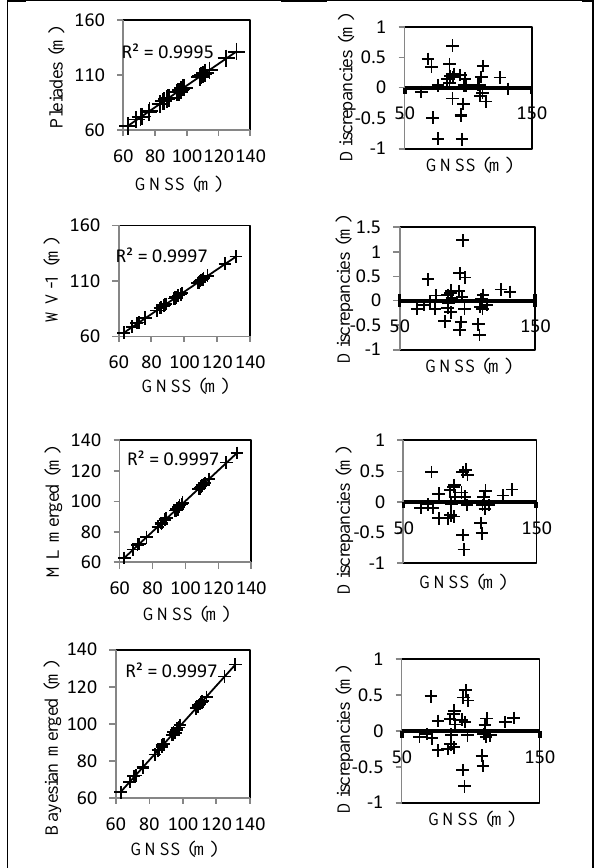
Figure 5. Comparison of the correlation and scatter plot for the input data and merging results using Maximum Likelihood and Bayesian techniques against checkpoints (CPs). First row is for Pleiades vs. Checkpoints, second row is for WV-1 vs. Checkpoints, third row is for Maximum Likelihood vs. Checkpoints, and fourth row is for Bayesian merging - range ±0.25m window 3x3 vs. Checkpoints.